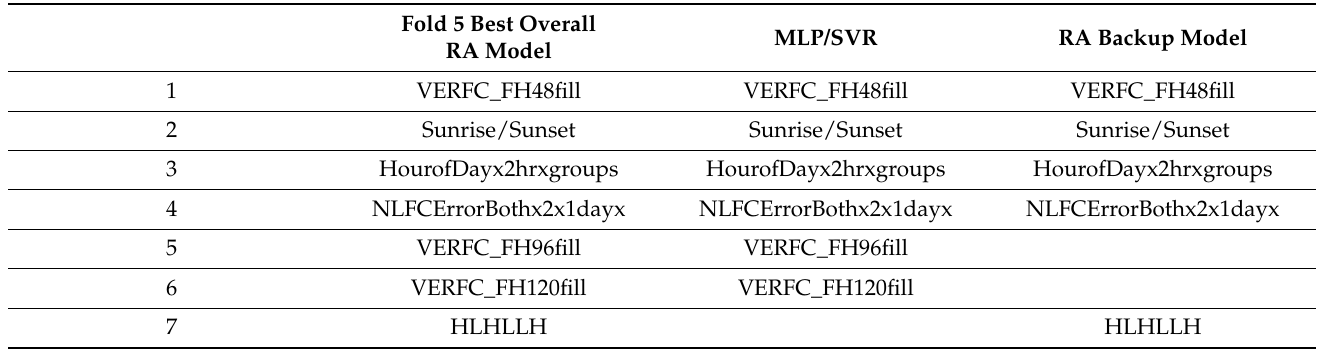
Table 10. IVs found in Best RA, NN/SVR, RA Backup